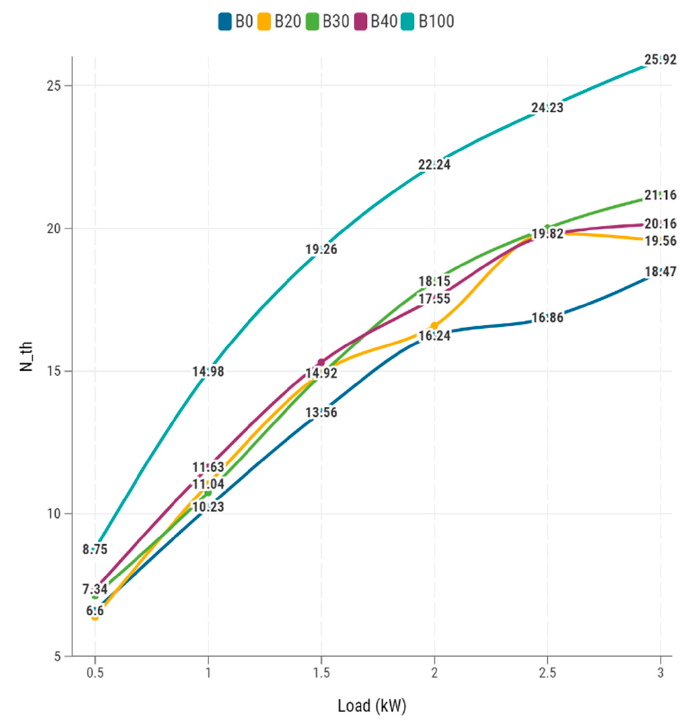
Figure 9. BTE at different loads.